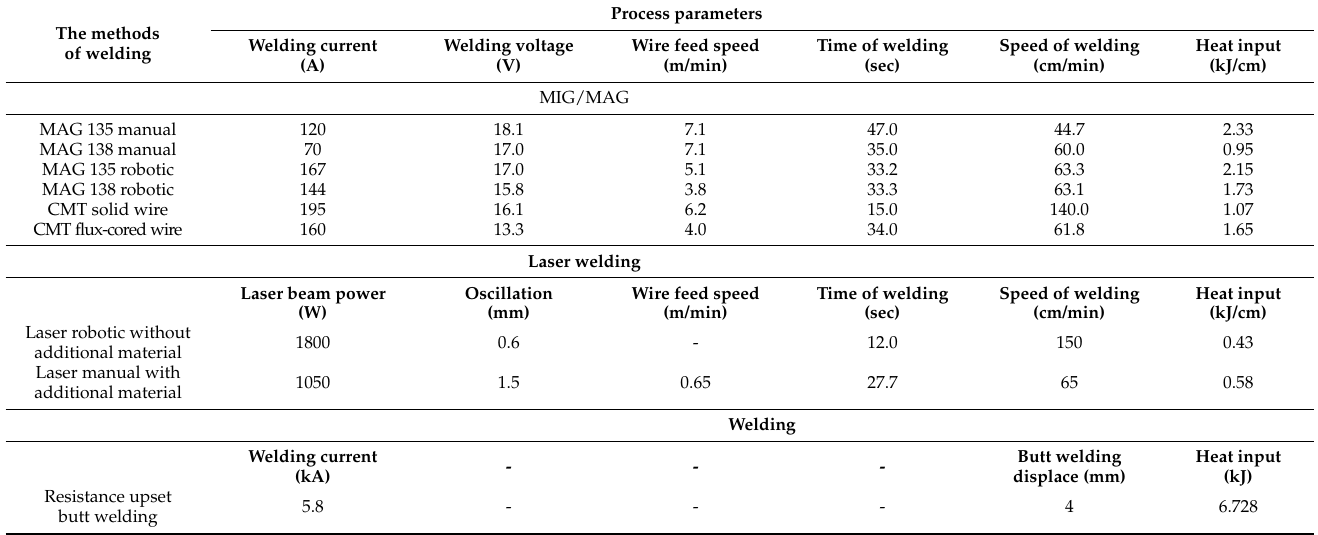
Table 1. Methods of welding thin-walled steel elements with the applied process